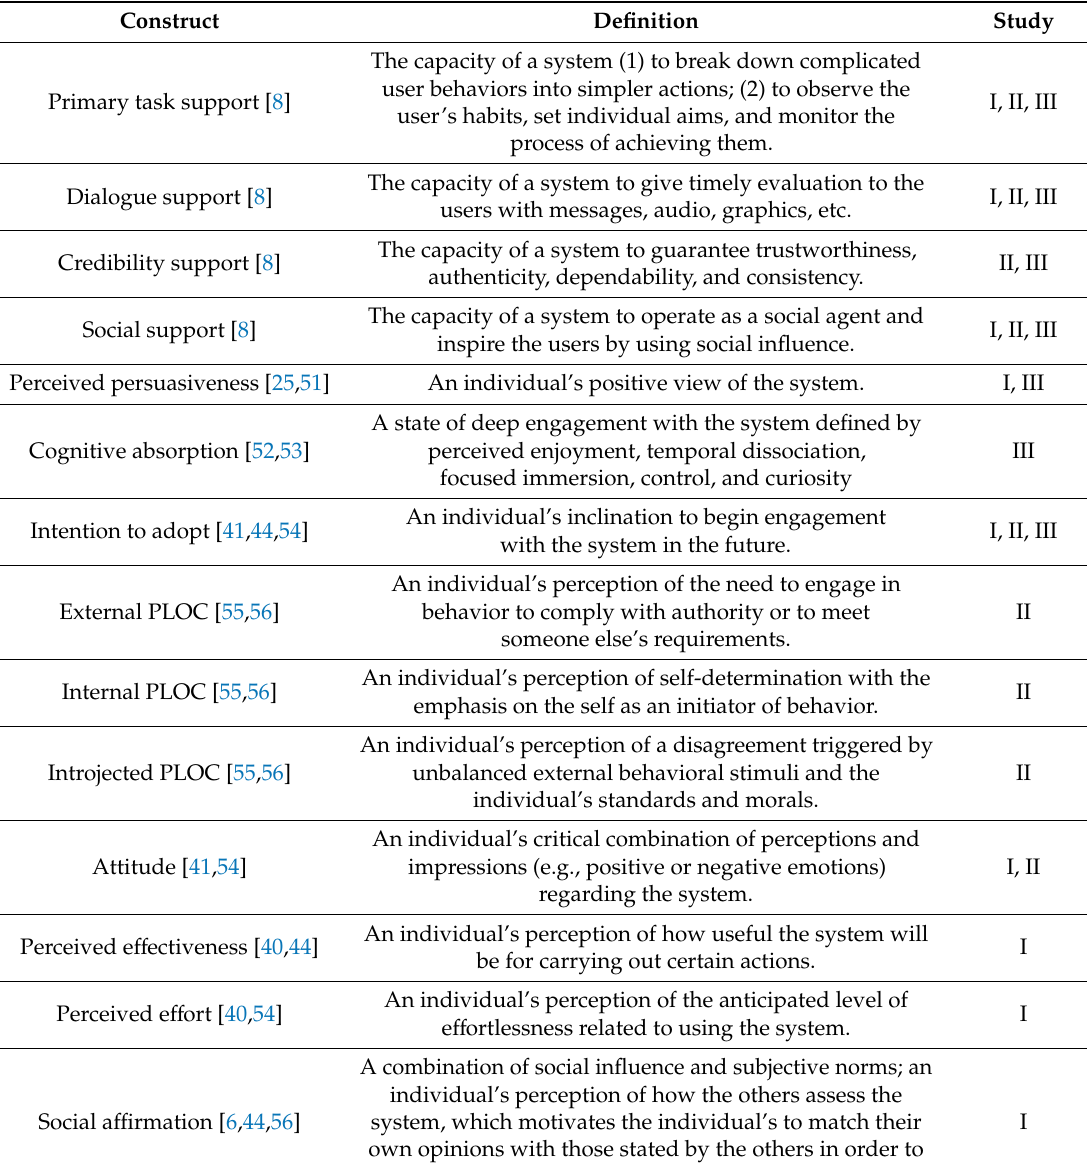
Table 1. Constructs used in Studies